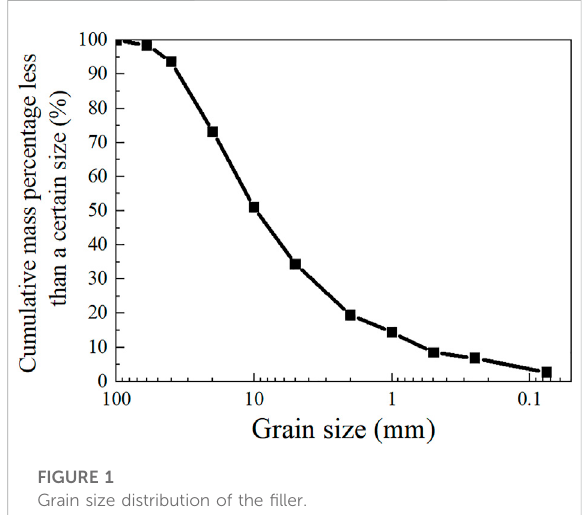
FIGURE 1 Grain size distribution of the fi